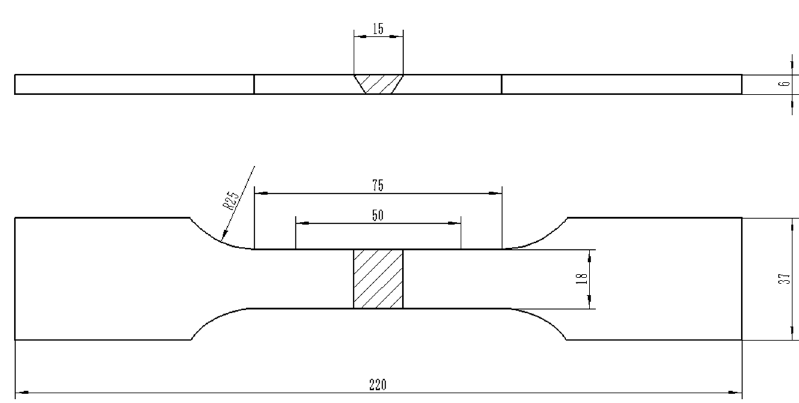
Figure 2. Schematic diagram of flat tensile specimen.